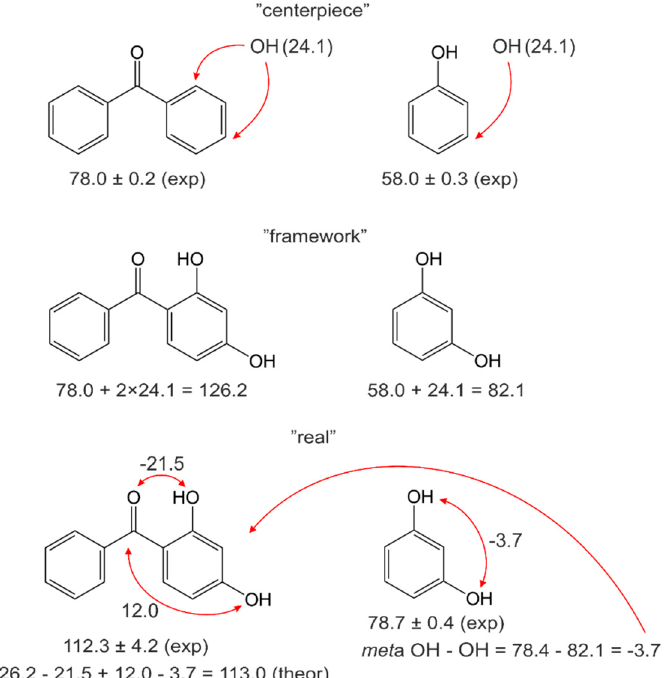
Figure 7. Example of calculation of the enthalpy of vaporisation, ∆ (cid:2922)(cid:2917) (cid:1834) (cid:2923)(cid:2925) (298.15 K), of 2,4 ‐ dihydroxy ‐ benzophenone using the “centerpiece” approach with the numerical values from Table 9. All numbers are given in kJ ∙ mol − 1 .